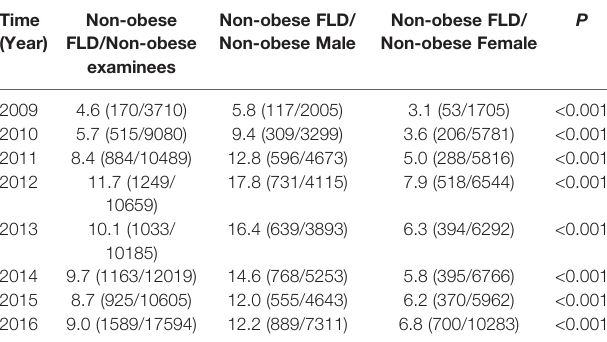
TABLE 2 | Prevalence of non-obese FLD in non-obese physical examinees from 2009 to 2016 [%(n+/n)].